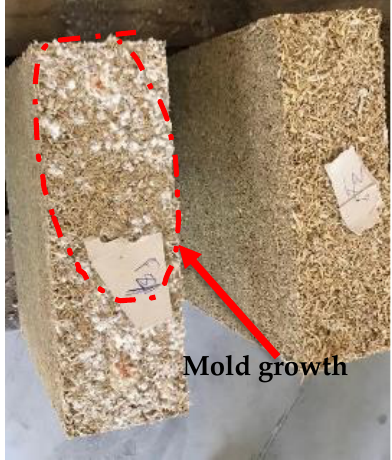
Figure 11 . Rapeseed concrete samples made with the M-16 aggregates. Figure 11. Rapeseed concrete samples made with the M-16